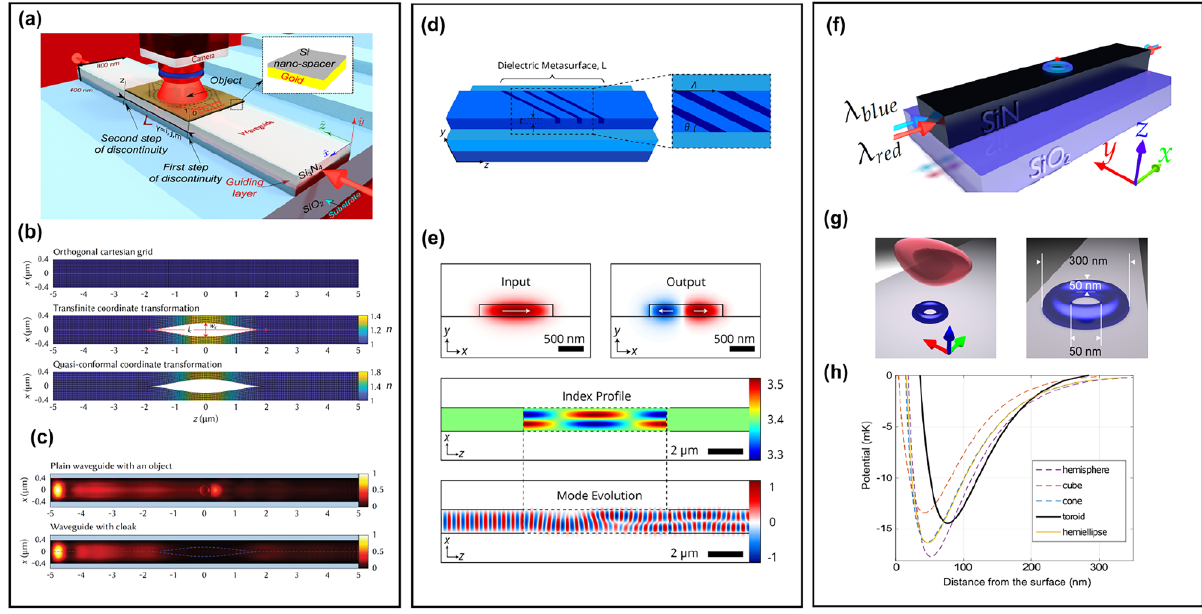
Figure 8: On-chip nanophotonic devices for emerging applications: (a) Schematics of the composite plasmonic waveguide structure and materials to study the invisibility cloaking scheme. (b) Transformed grids and refractive index of the evanescent field waveguide cloak. (c) Surface intensities of waveguide evanescent field cloak on a chip with (up) Reference waveguide with cylindrical object placed on top and (down) with cloak a cylindrical object. ((a) and (c) are reproduced from [6]). (d) Schematic con fi guration of the proposed mode